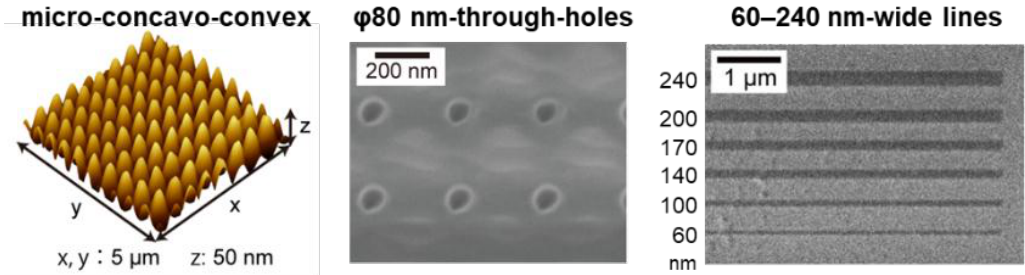
Figure 3. Precise and arbitrary-shaped micro / nanostructures of poly(L-lactic acid) (PLLA) obtained by focused ion beam (FIB) direct etching.